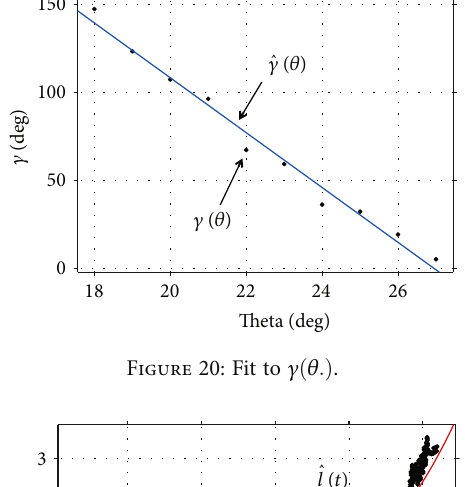
Figure 19: Deformation in throat area when ablation or deposition occurs.